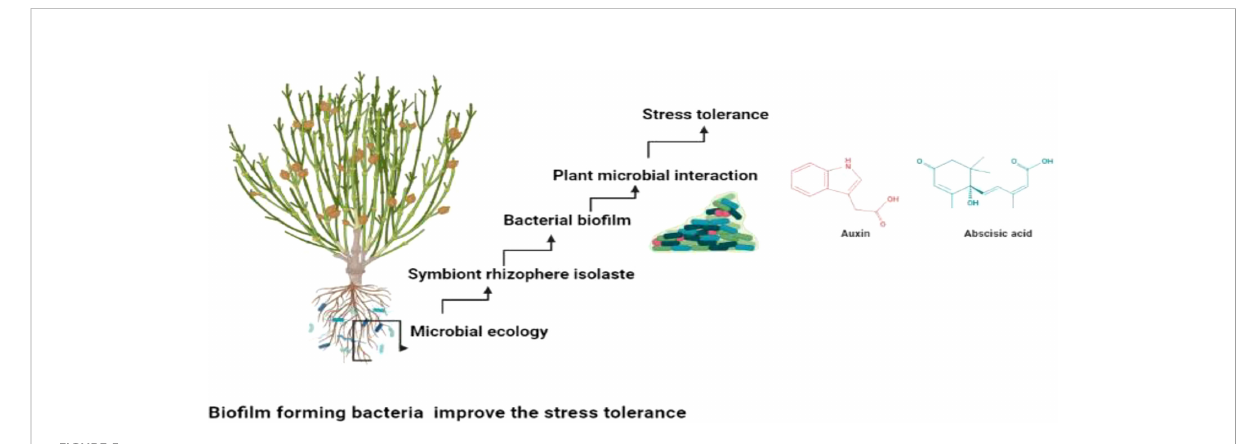
FIGURE 5 Bio fi lm producing isolates mitigate stress tolerance through plant microbial